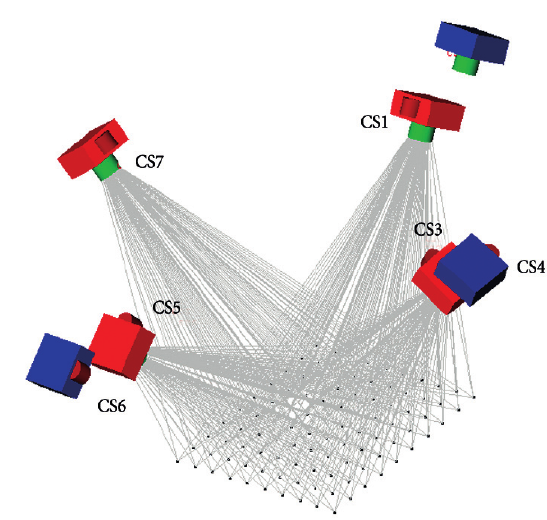
Fig. 3. 3D model of the calibration field including the station